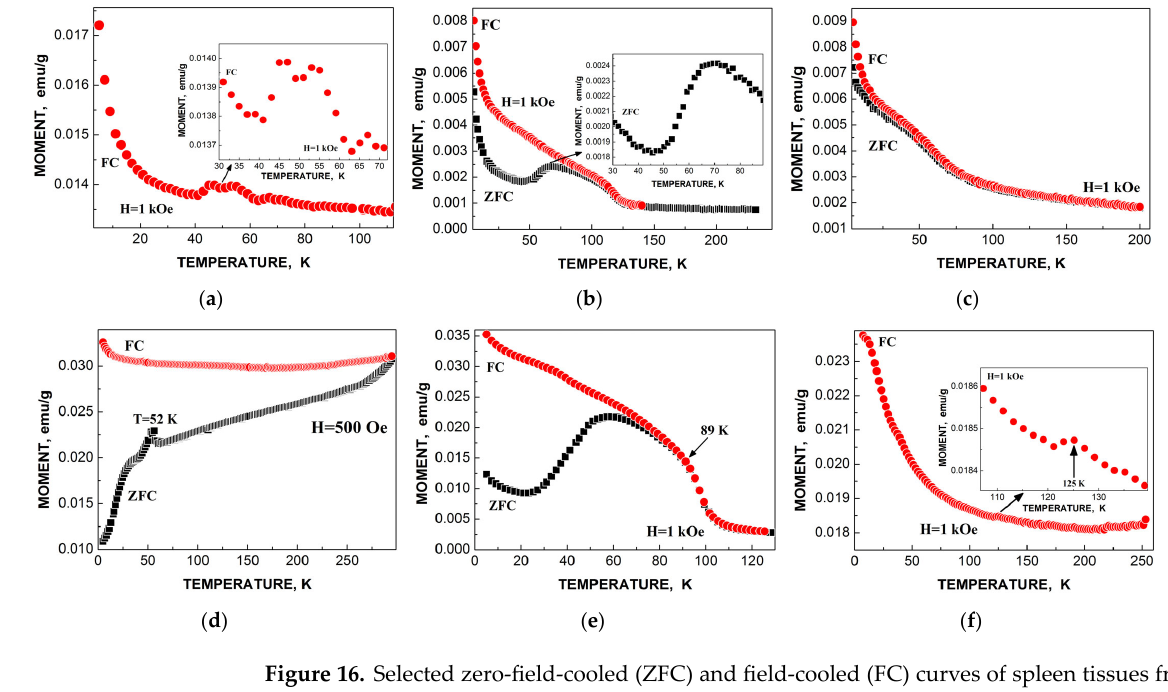
Figure 16. Selected zero ‐ field ‐ cooled (ZFC) and field ‐ cooled (FC) curves of spleen tissues from normal human “1” ( a ) and patients with mantle cell lymphoma “G” ( b ), marginal zone lymphoma “P” ( c ) and “Do” ( d ), acute myeloid leukemia “Ch” ( e ) and primary myelofibrosis “B” ( f ). Adapted from Ref. [59] with permission from Springer Nature: Cell Biochemistry and Biophysics, “The iron state in spleen and liver tissues from patients with hematological malignancies studied using magnetization measurements and Mössbauer spectroscopy”, Alenkina I.V., Vinogradov A.V., Felner I., Konstantinova T.S., Kuzmann E., Semionkin V.A., Oshtrakh M.I., ©2019.